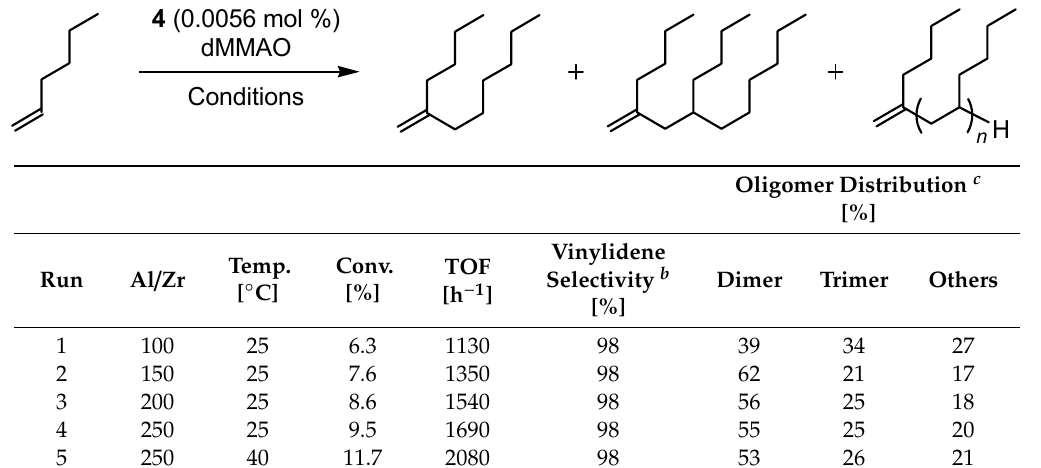
Table 1. Oligomerization of 1-hexene using precatalyst 4 activated with dMMAO a .